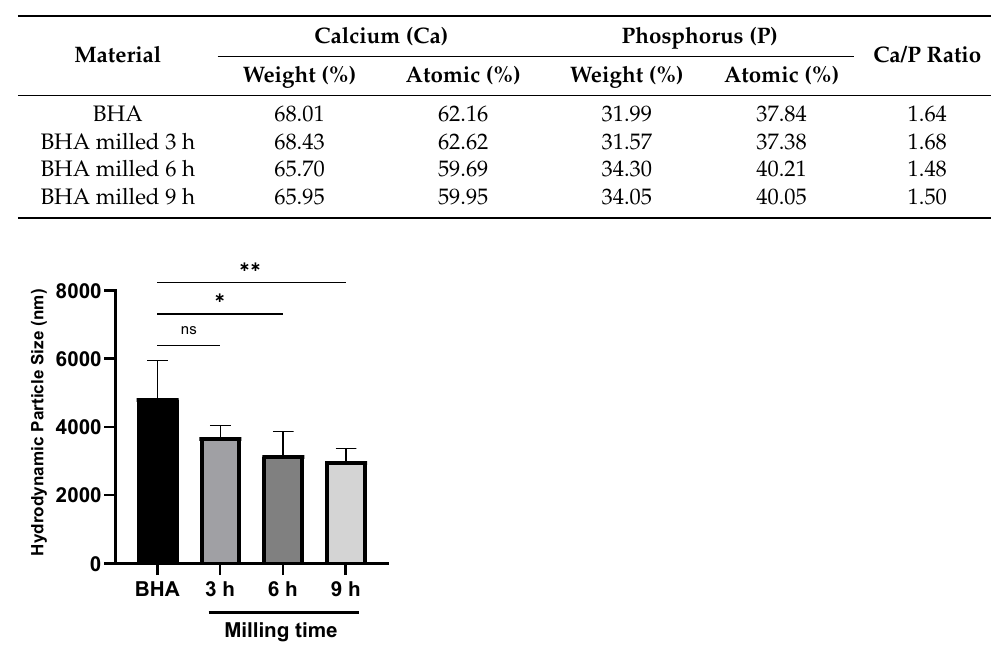
Figure 5. The hydrodynamic particle size of milled and unmilled BHA. Each bar shows the mean ± SD value. * p < 0.05, ** p < 0.01 based on a one-way ANOVA test.